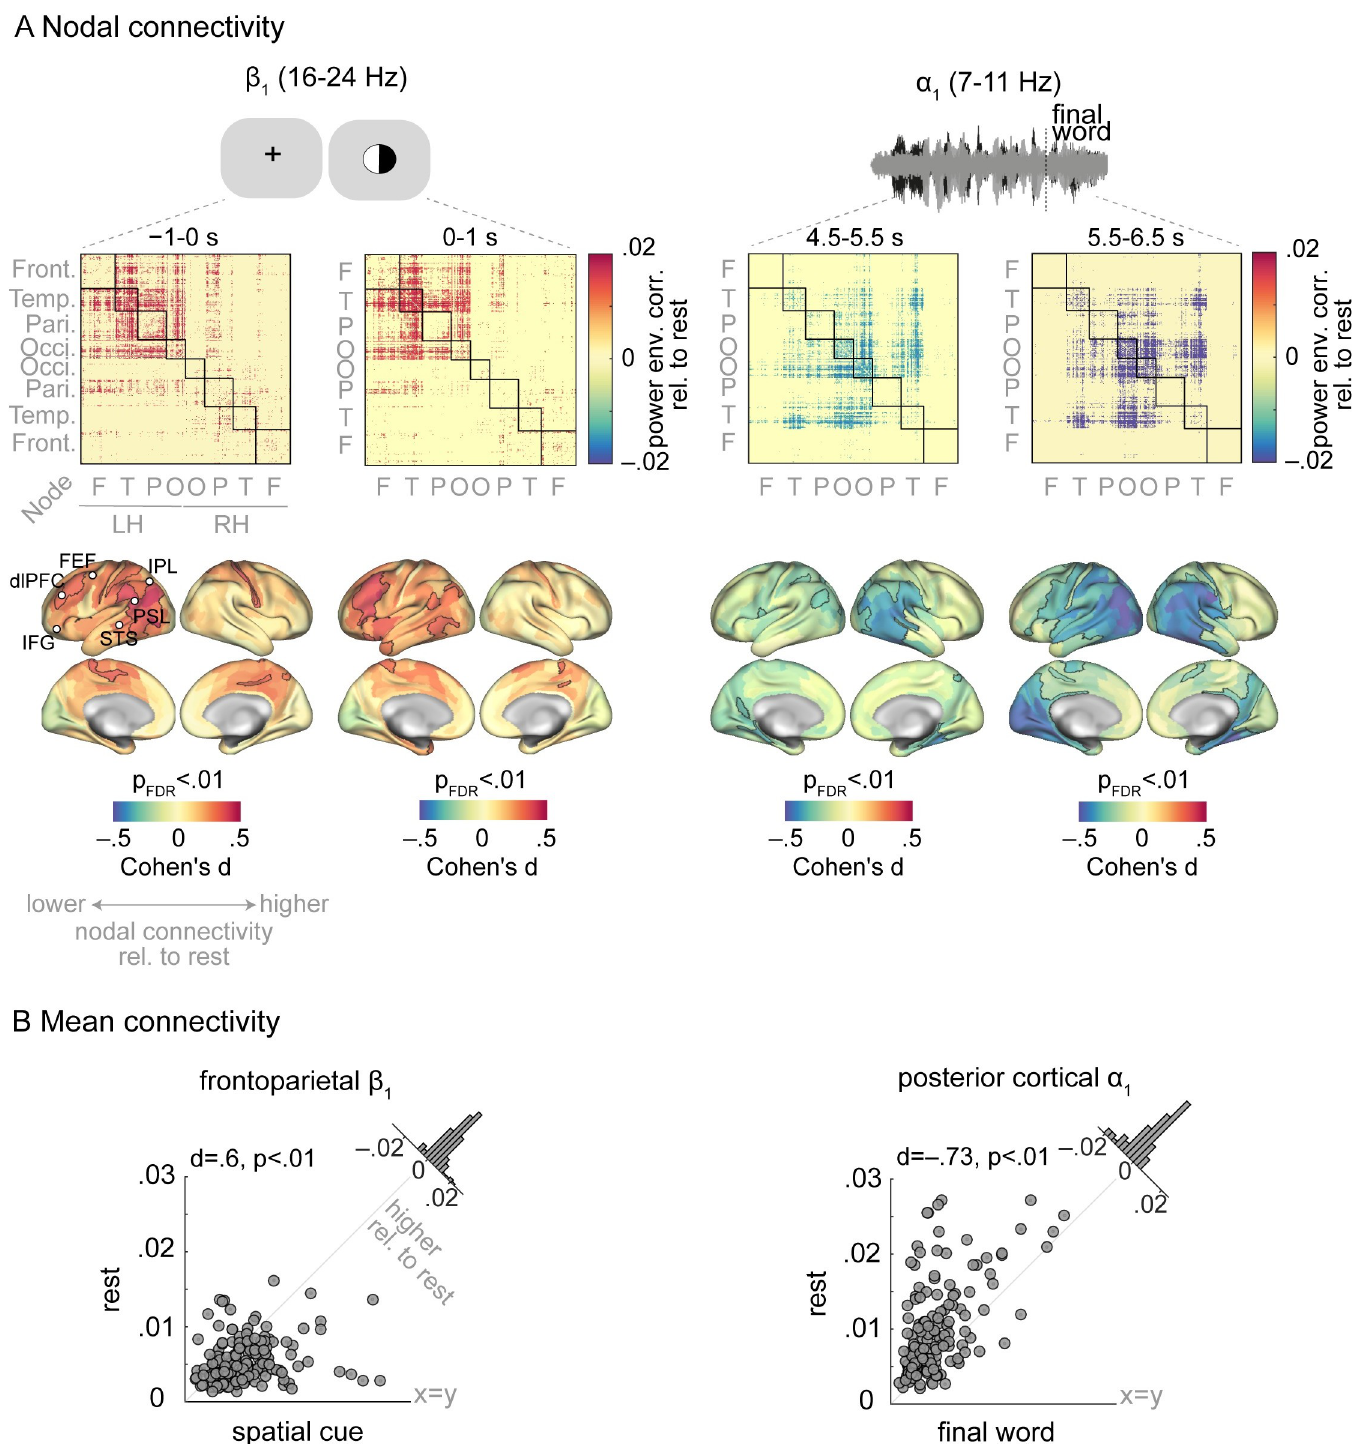
Fig 5. Cortical connectivity dynamics of α / β oscillations during the listening task. (A) To assess whether and how intrinsic alpha and low-beta oscillations regulate their cortical connectivity during attentive listening, connectivity difference maps (i.e., task minus rest) were derived per frequency band. Task connectivity was estimated by concatenating 1-s windowed signals across all 240 trials (4-min data). In anticipation of and during the spatial cue presentation, β 1 connectivity was increased relative to its intrinsic connectivity mainly within the left hemisphere (first panel). This hyperconnectivity was significant across frontoparietal regions (brain surfaces; significant nodes are outlined in black). The same analysis revealed a significant α 1 hypoconnectivity during final-word presentation (second panel). Nodes correspond to cortical